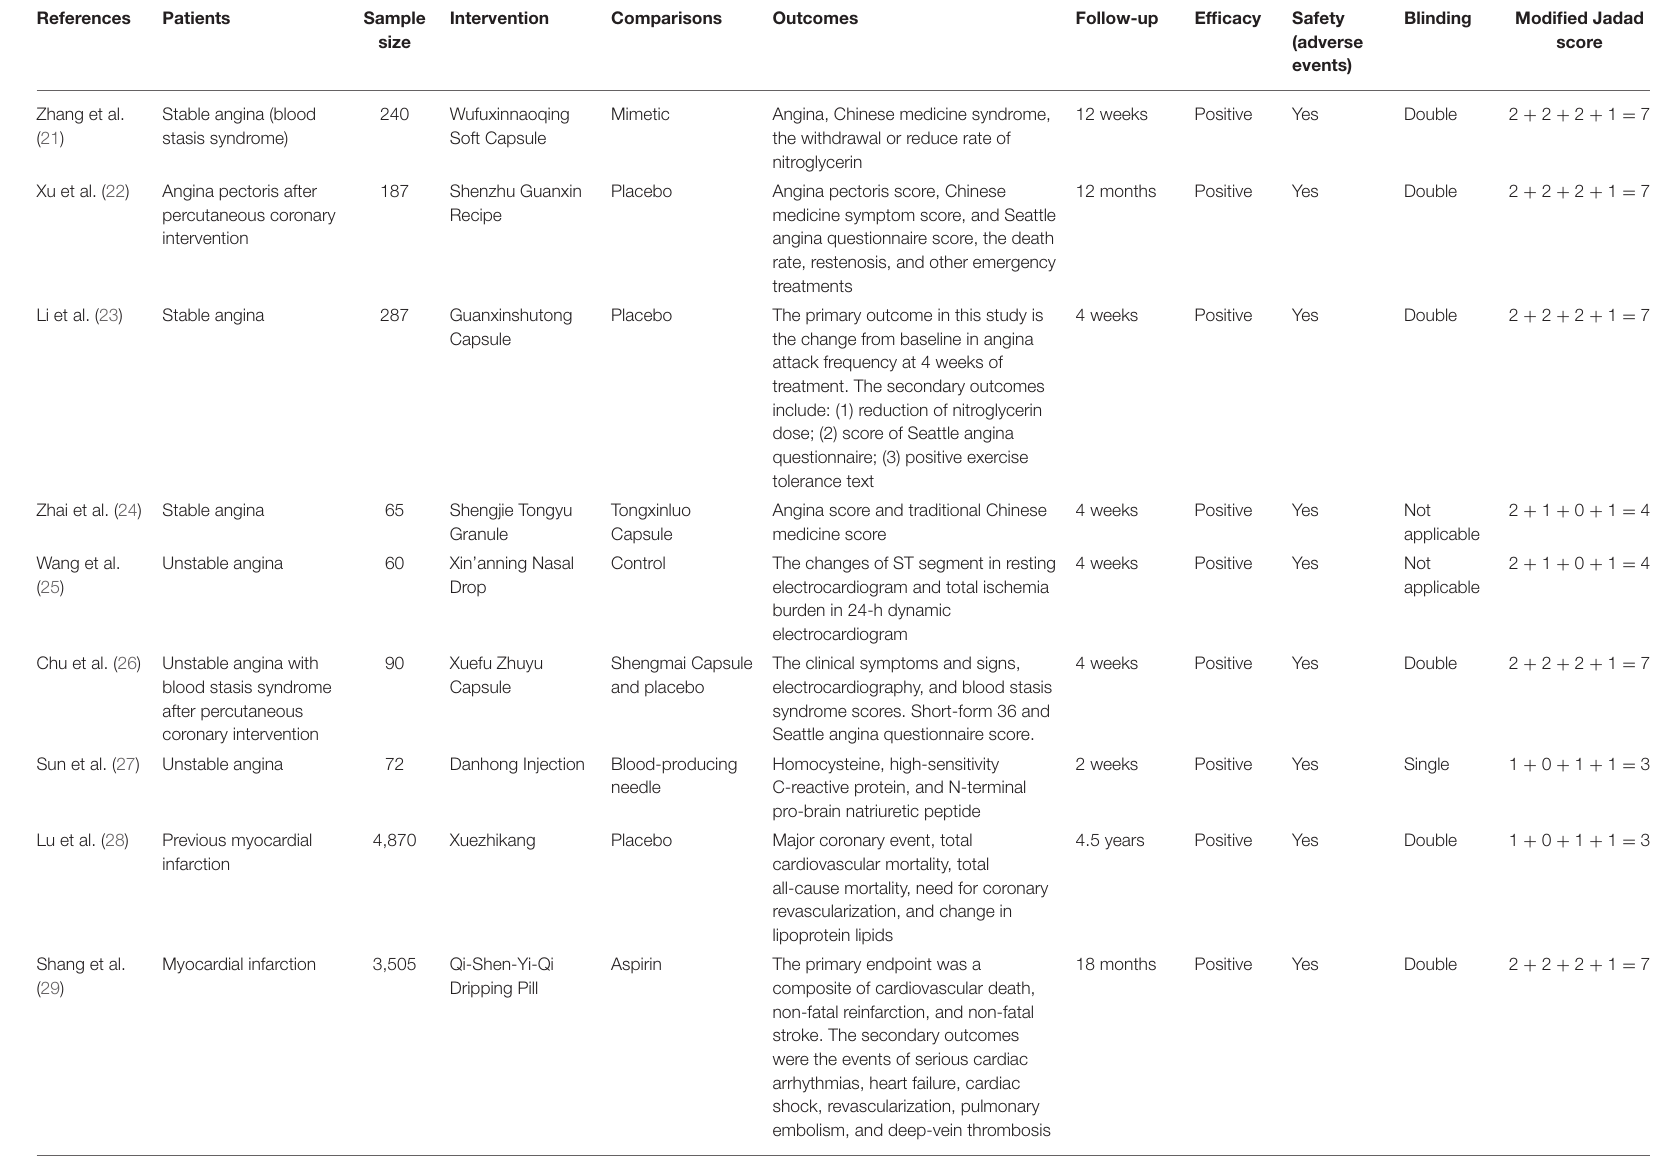
TABLE 1 | Details of major randomized controlled